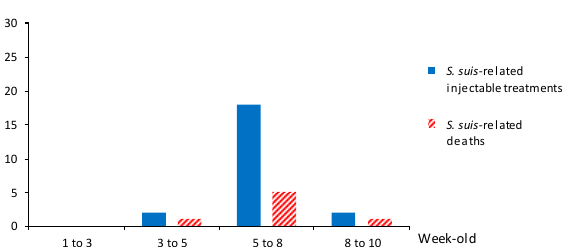
Table 3. Distribution of mortality among piglets from vaccinated and non-vaccinated sows.